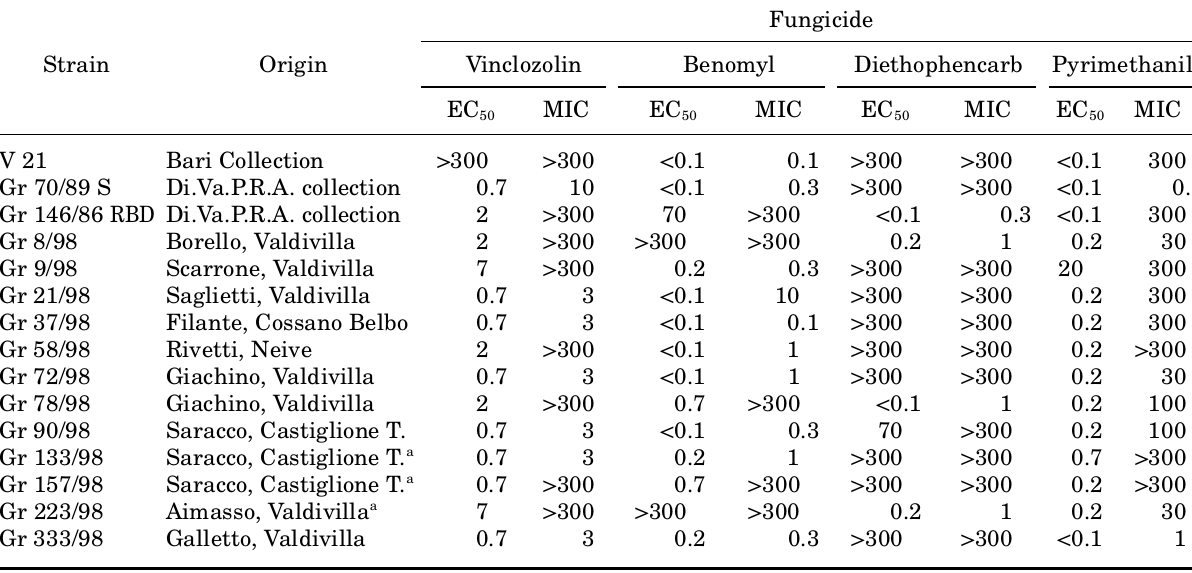
Table 5. Efficacy of botryticides of different classes against isolates of Botrytis cinerea isolated from Italian vine- yards in 1998. Results are expressed as Effective Concentration 50 (EC (MIC) in